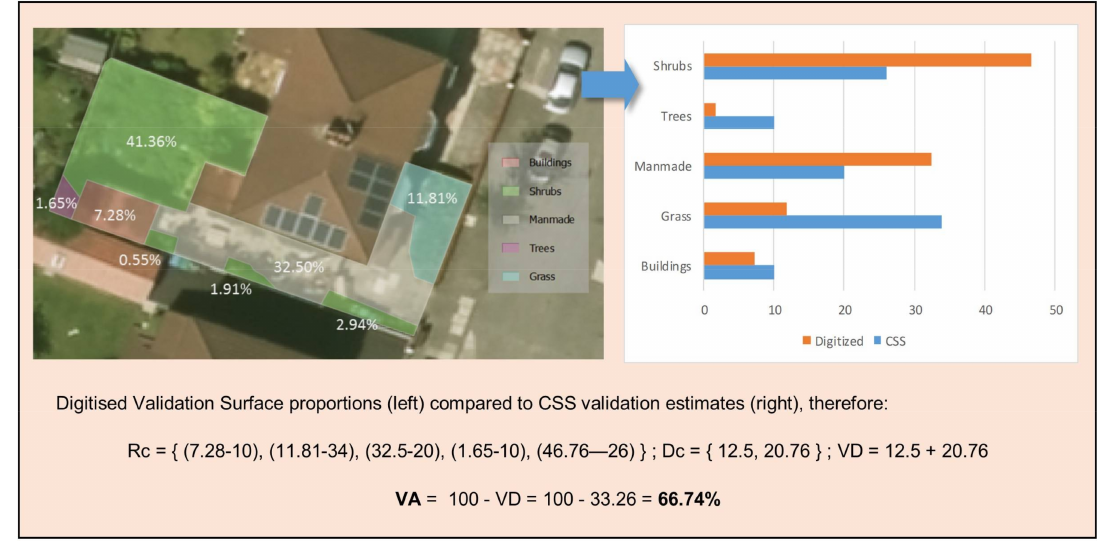
Figure 4. A worked example of the validation methodology.